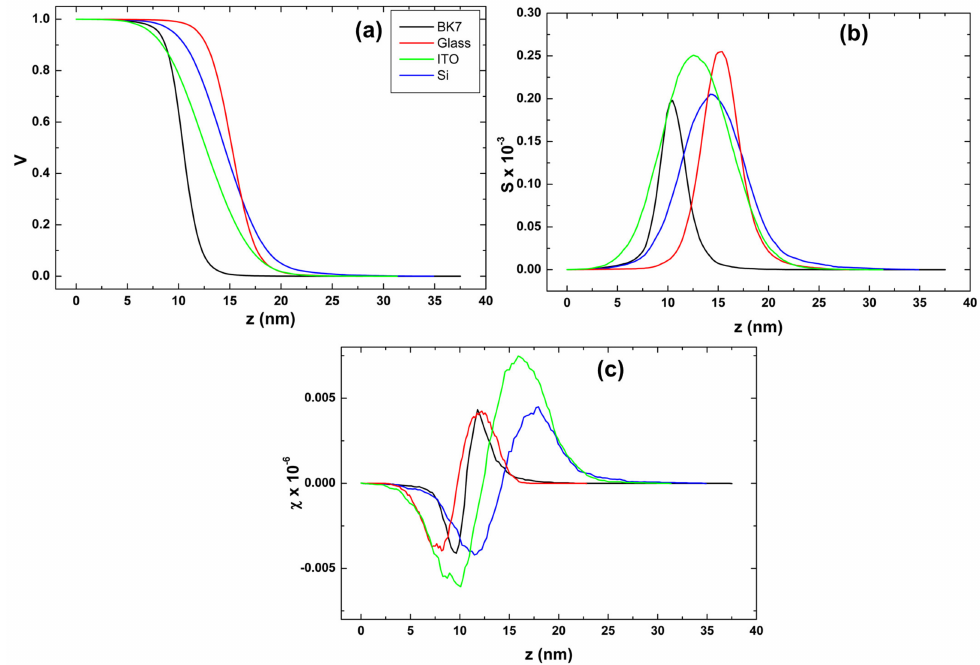
Figure 4. The MFs of Cu/Cr films deposited on BK7, glass, ITO, and Si substrates for ( a ) Minkowski volume, ( b ) Minkowski boundary, and ( c ) Minkowski